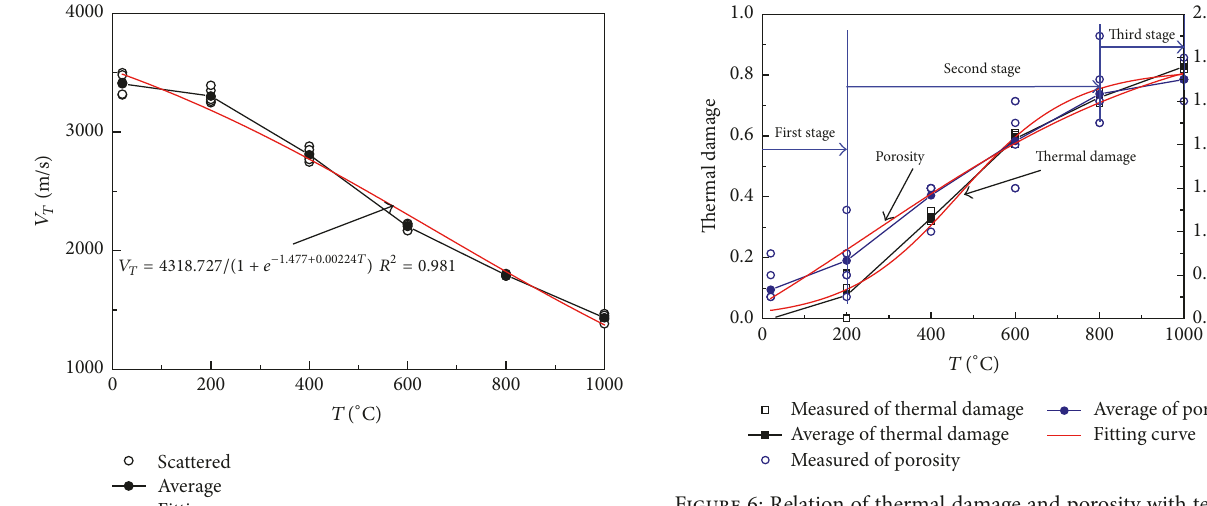
Figure 6: Relation of thermal damage and porosity with tempera- ture.